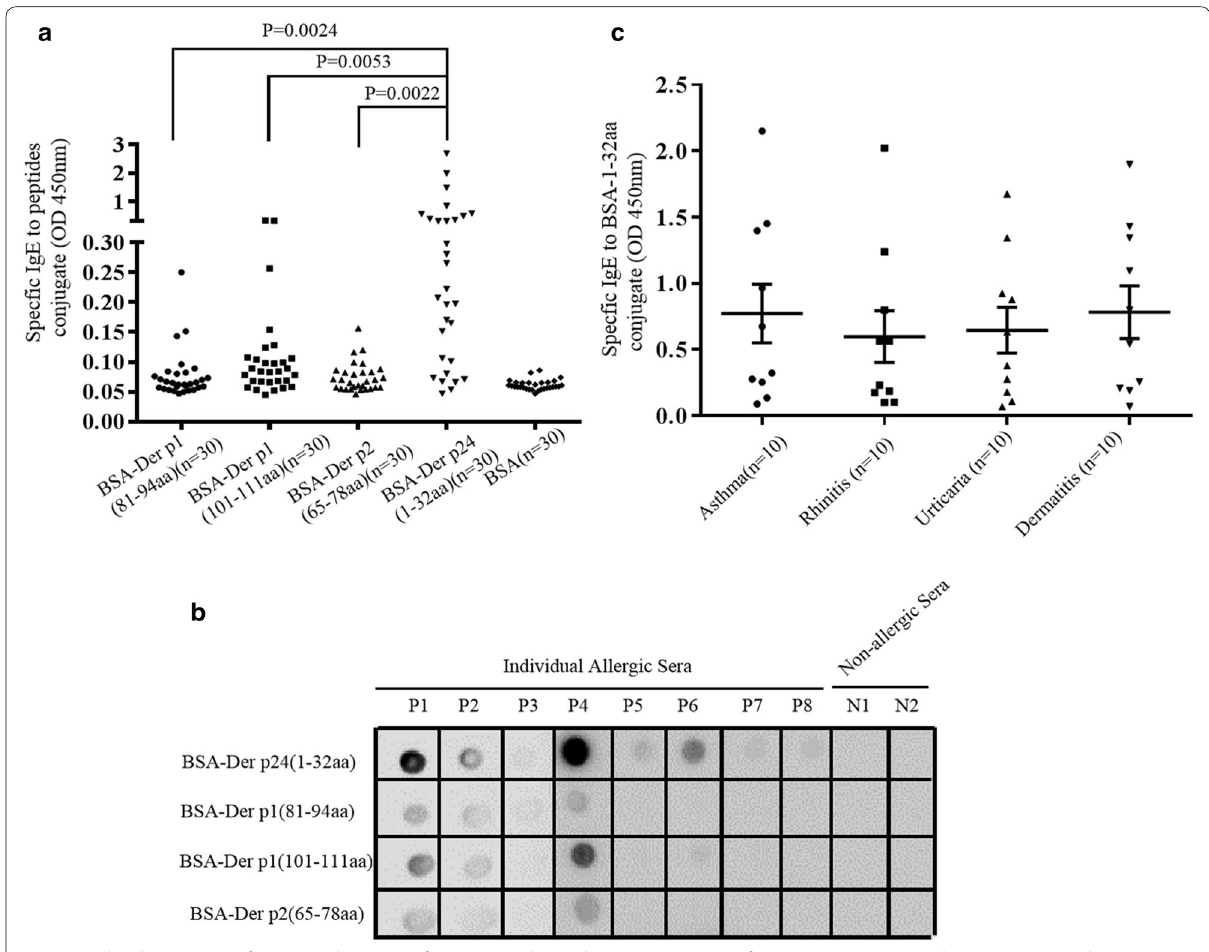
Fig. 5 IgE binding activity of N‑terminal epitope of Der p 24 and main linear IgE epitopes of Der p 1 or Der p 2. a Indirect IgE‑ELISA with serum samples from HDM‑sensitized patients (N 30) and non‑allergic controls (N 2). b IgE‑dot blot analysis with sera from HDM allergic patients (N = = P1–P8) and non‑allergic individuals (N 2, N1–N2). c Indirect IgE‑ELISA for detecting specific IgE against immunodominant IgE epitopes of Der p 24 = with individual serum samples from HDM allergic patients with symptom manifestations of only asthma, rhinitis, urticaria, or dermatitis (N manifestation group). Mean values are shown with standard errors and p values < 0.05 were considered